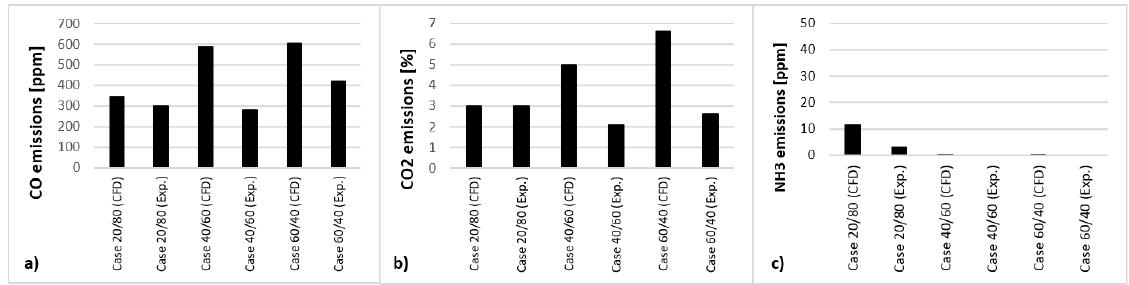
Figure 3. Isothermal results at different axial positions. Experiments (solid, orange line) and numerical (dashed, black line).